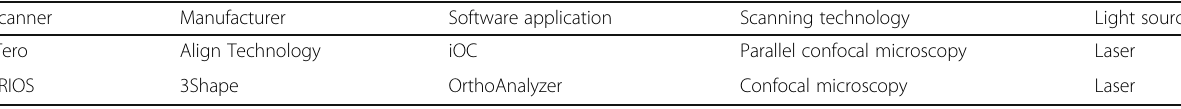
Table 1 Two commercially available intraoral scanners used in this study